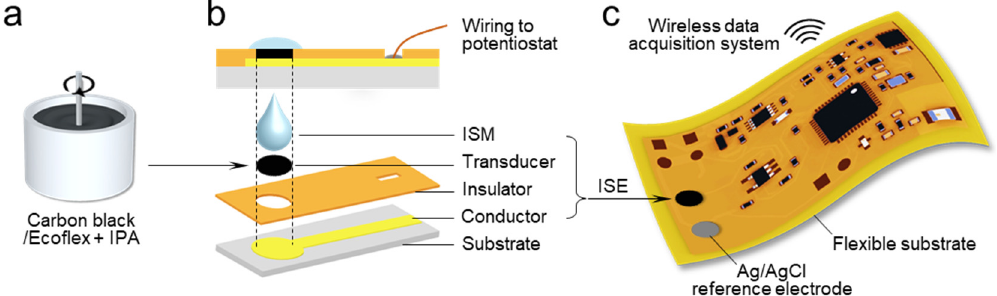
Figure 2. Fabrication process of an all-solid-state film ISE. ( a ) Schematic illustration showing simple procedure for a CB / Ecoflex composite with long-term (several months) storage at room temperature (RT). ( b ) Illustrated structure of film ISE, including deposited ion-selective membrane (ISM), CB / Ecoflex transducer, insulator, and Au conductor on Si wafer. ( c ) Direct integration of fabricated ISE and Ag / AgCl reference electrode on Cu pads in the flexible circuit for wireless data acquisition.